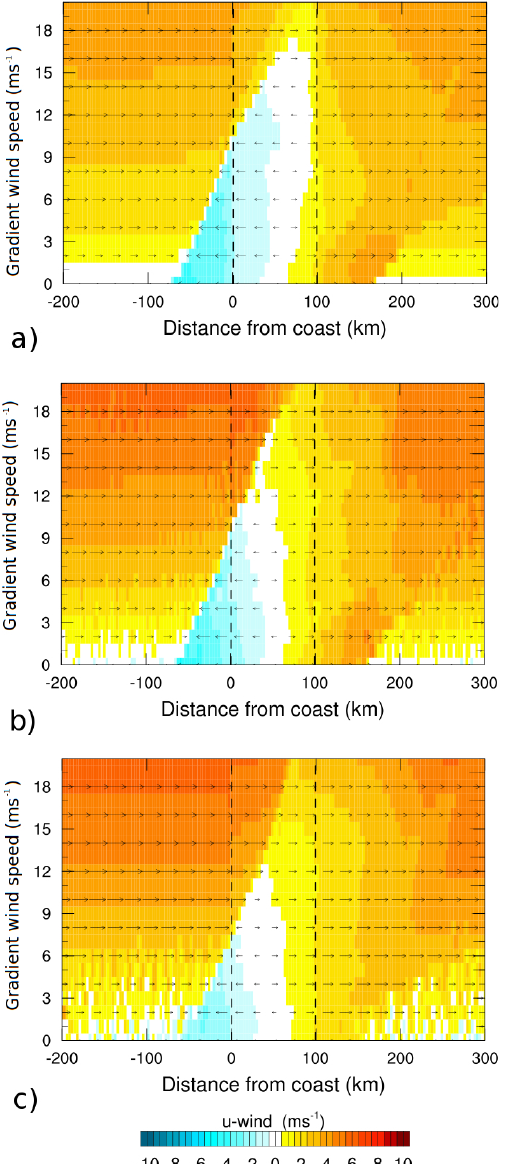
Fig. 20. Variations of the 10m u-wind component (color) and vec- tor wind speeds (arrows) with increasing west-east gradient wind strength at 17:00UTC using the (a) YSU, (b) MYJ and (c) MYNN PBL schemes without Coriolis acceleration. Distances are measured from the western coastal boundary with each coastline being de- picted by the dashed lines. In all cases, the SST was 287K.